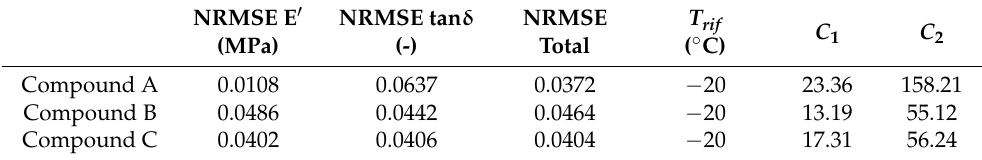
Table 2. NRMSEs and identified WLF coefficients for compounds A, B, and